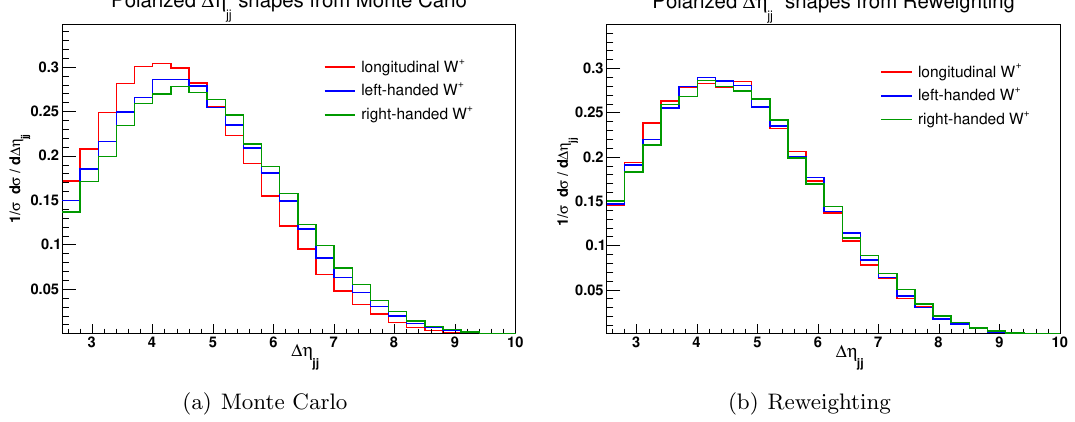
W + Z scattering: (cid:1) (cid:17) jj normalized distributions for a polarized W + , obtained with polarized amplitudes (left side) and with the reweighting procedure (right side), in the re- gion 60 GeV < p W < 90 GeV ; 1 < (cid:17) W < 2, in the absence of lepton cuts and without neu- t j j trino